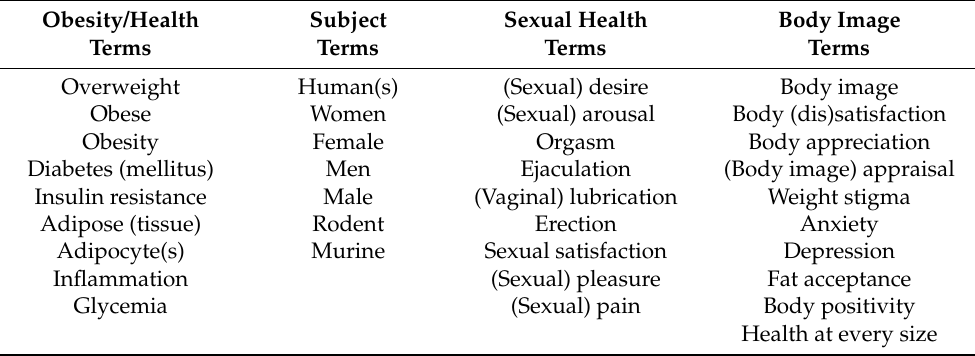
Table 2. Key terms from literature